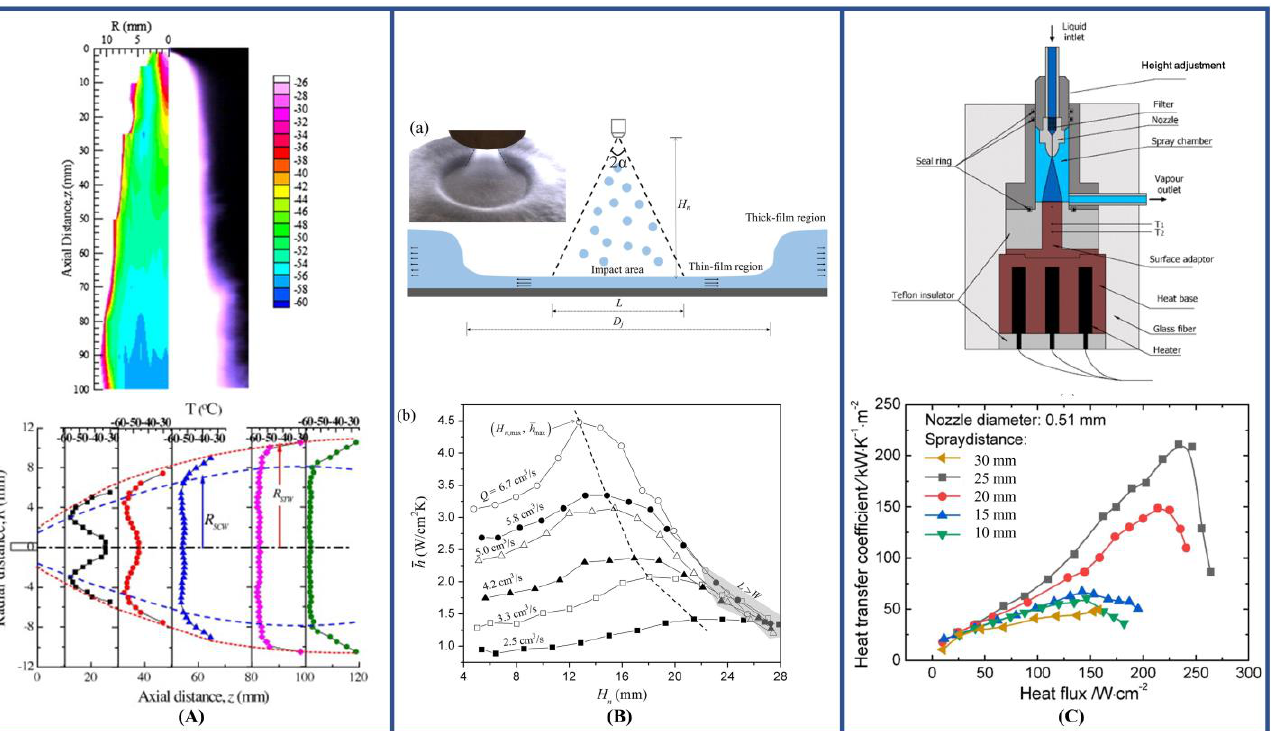
Figure 4. Influence of spray distance on cooling effect in experiment. ( A ): Two-dimensional (Z × R) temperature field (left half) compared with a photo image of the R134A spray (right half); Radial temperature curves of R134A at five spray distances: z = 10, 30, 50, 80 and 100 mm [74]. ( B ): Spray impact on the surface could be divided into three regimes: impact regime, thin-film regime and thick-film regime ( a ); heat transfer coefficient ℎ̅ averaged over the heater area ( b ); 𝐻 𝑛 represents the spray height for varied flow rates [70]. ( C ): Full schematic of spray chamber; influence of injection distance on the heat transfer coefficient with heat flux [11].